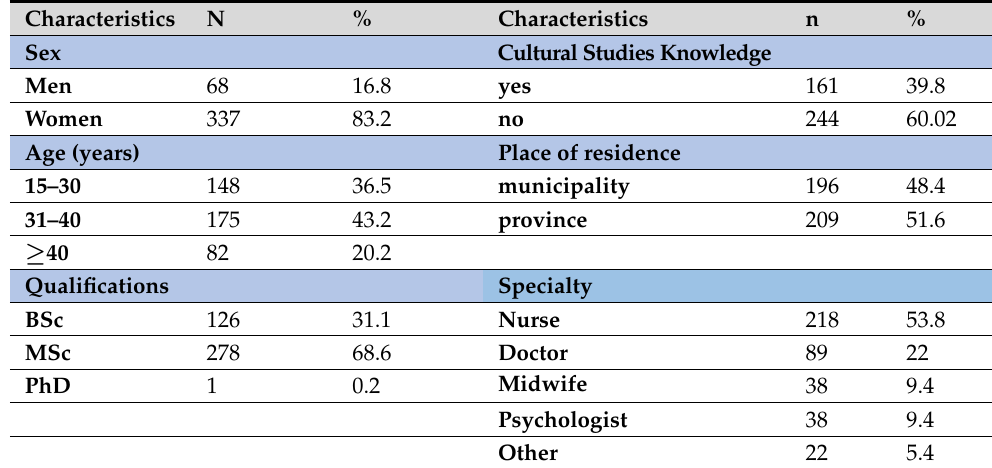
Table 2. Demographic